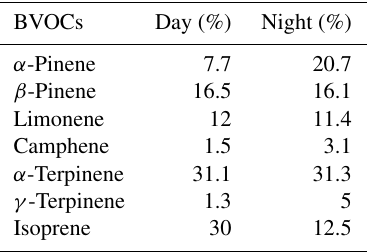
Table 3. Relative contributions of individually detected biogenic volatile organic compounds (BVOCs) to the total calculated OH re- activity BVOC fraction. Daytime BVOC OH reactivity accounted for a maximum value of 9s − 1 , with an average of 2 ± 2s − 1 . Night- time BVOC OH reactivity fraction accounted for a maximum value of 0.5s − 1 , with an average of 0.1s − 1